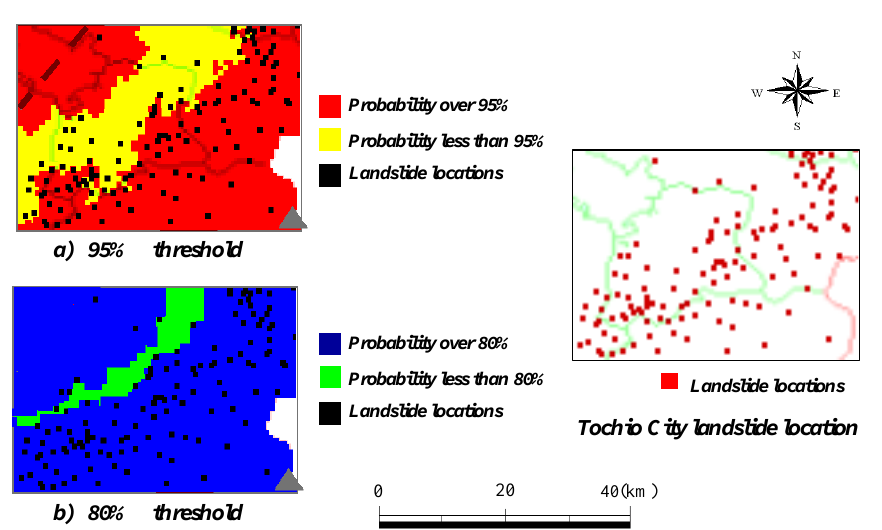
Figure 7. Observed landslide locations in Tochio city Fig. 7. Observed landslide locations in Tochio city.